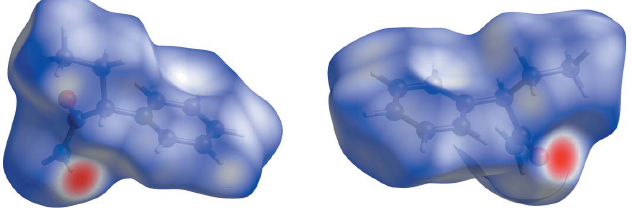
Figure 4 Hirshfeld surface for the rac -2 polymorph plotted over d norm in the range (cid:3) 0.4994 to 1.0567 a.u.